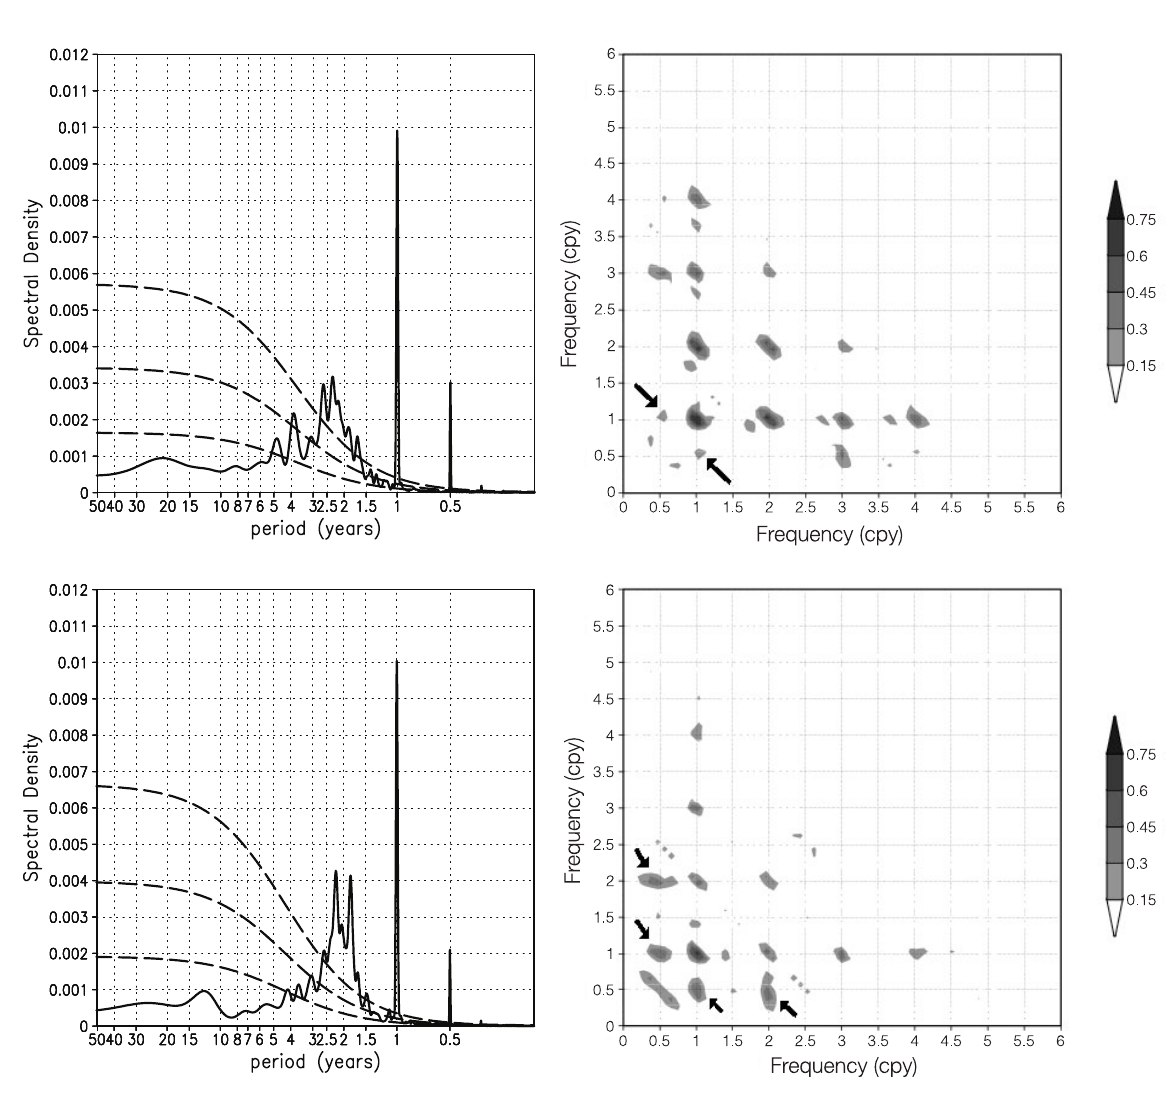
Fig. 1. Power spectrum (left) and bicoherence of the Niño3 SST Index for: ( top ) SINTEX simulation, ( bottom ) ECHAM4-OPYC. Spectra were computed using a Parzen lag-window of width 600 months for both